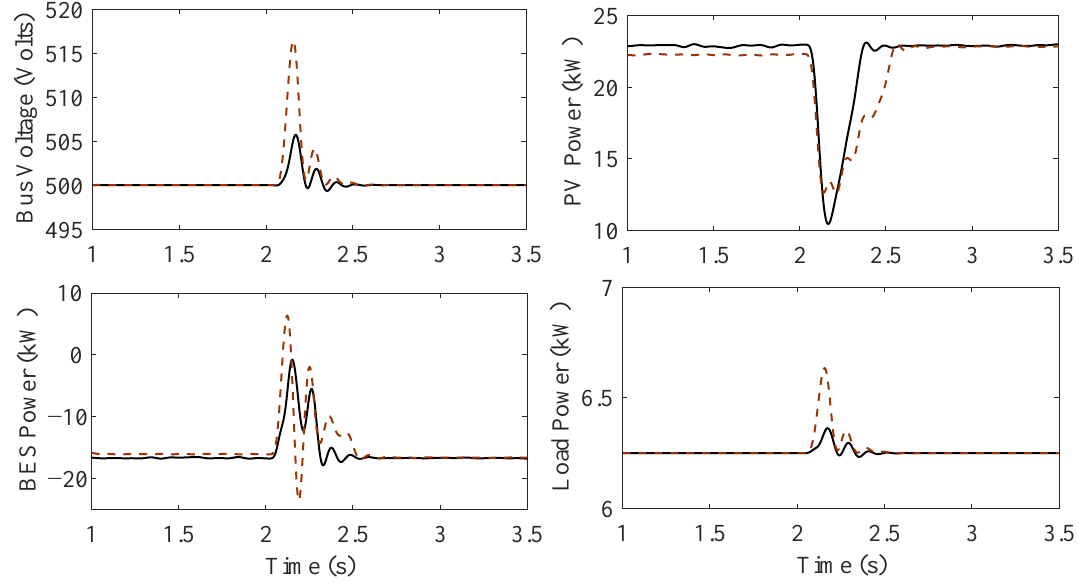
Figure 9. Bus voltage and different power responses under measurement